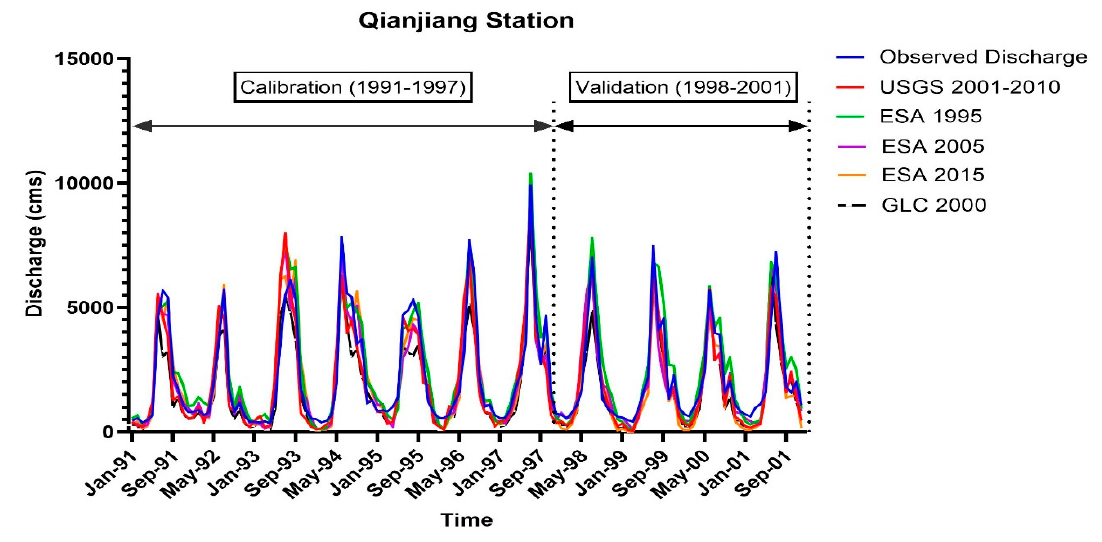
Figure 4. Simulated and observed discharge at Qianjiang Station.